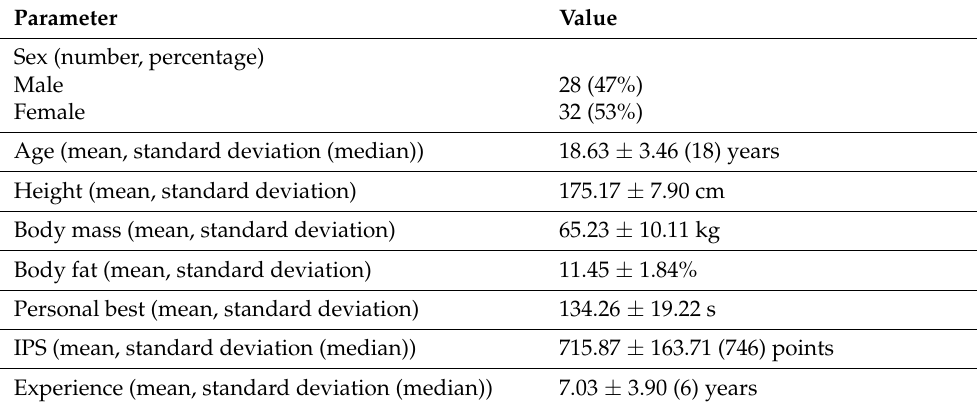
Table 1. Main demographic and anthropometric features of the sample. Abbreviation: IPS, Interna- tional Point